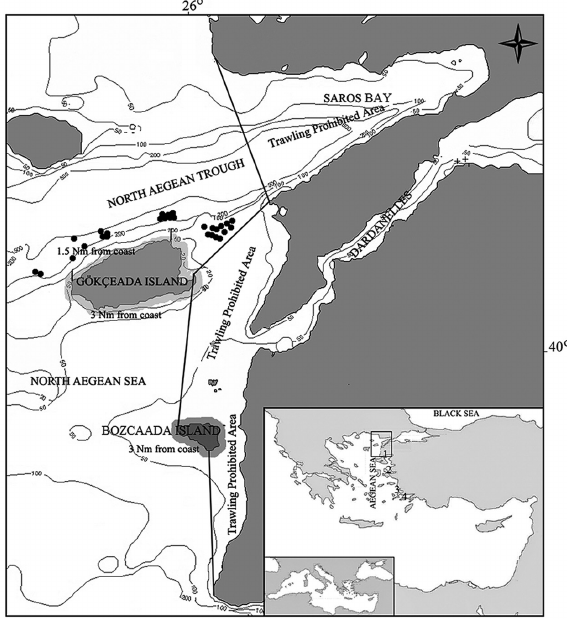
Fig. 1. – Map of the study area around Gökçeada Island (northeast- ern Aegean Sea; eastern Mediterranean) showing the position of the trawl samples analysed (circles). 1, Edremit Bay; 2, İ zmir Bay; 3, Güllük Bay; 4, Gökova